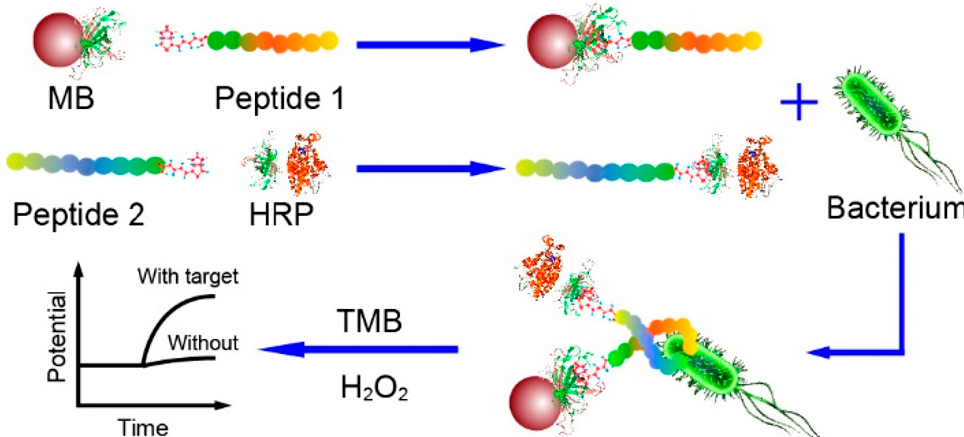
Figure 4. Schematic illustration of the potentiometric sandwich assay based on short antimicrobial peptide pairs for the detection of L. monocytogenes [118]. Copyright 2018, American Chemical Soci- ety.